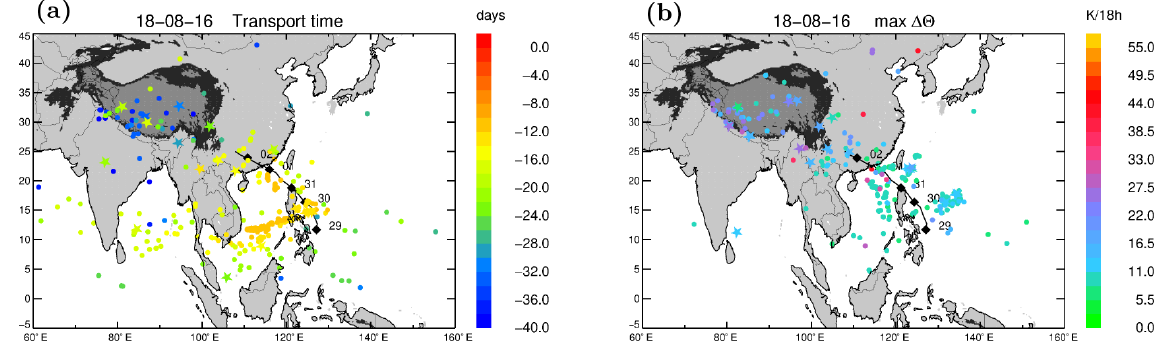
Figure 12. As Figs. 6 and 9 but for the typhoon-influenced case on 18 August 2016 (Case 3). Locations of end points and locations of the strongest updraft of trajectories initialised within the cirrus cloud which was found within the ATAL are indicated by star symbols. The 40- day backward trajectories are impacted by Typhoon Nida. Its storm track is shown (black line), and the location at noontime is additionally marked (black diamonds); the numbers indicate the day in July and August